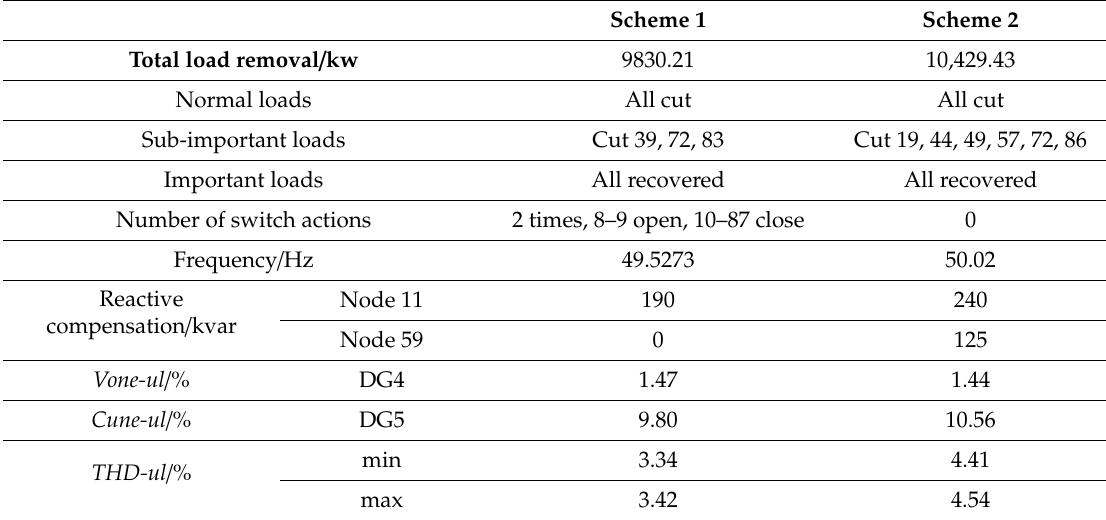
Table 1. Result of Scheme 1 and Scheme 2 for benchmark